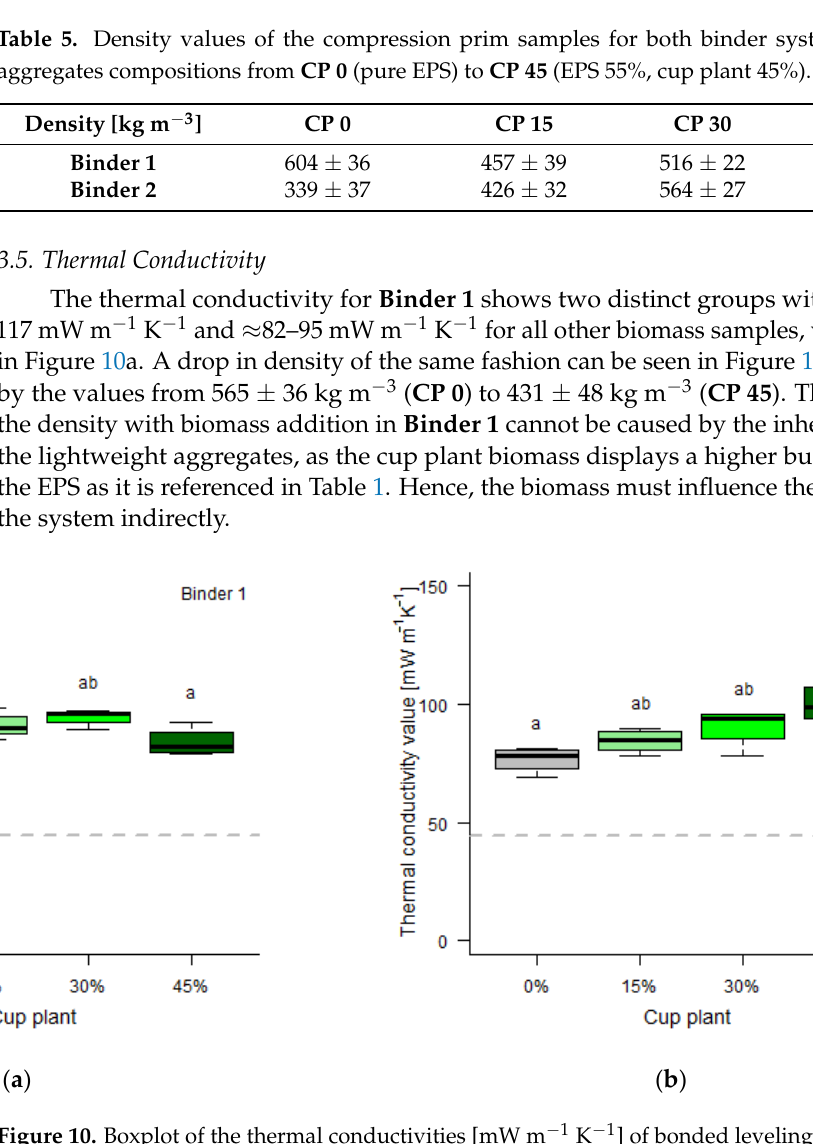
Figure 11. Scatterplot of sample density against thermal conductivity values for both Binders at different ratios of cup plant biomass and EPS [ n = 4, r = 0.868, p = 1.245 × 10 − 10 ].